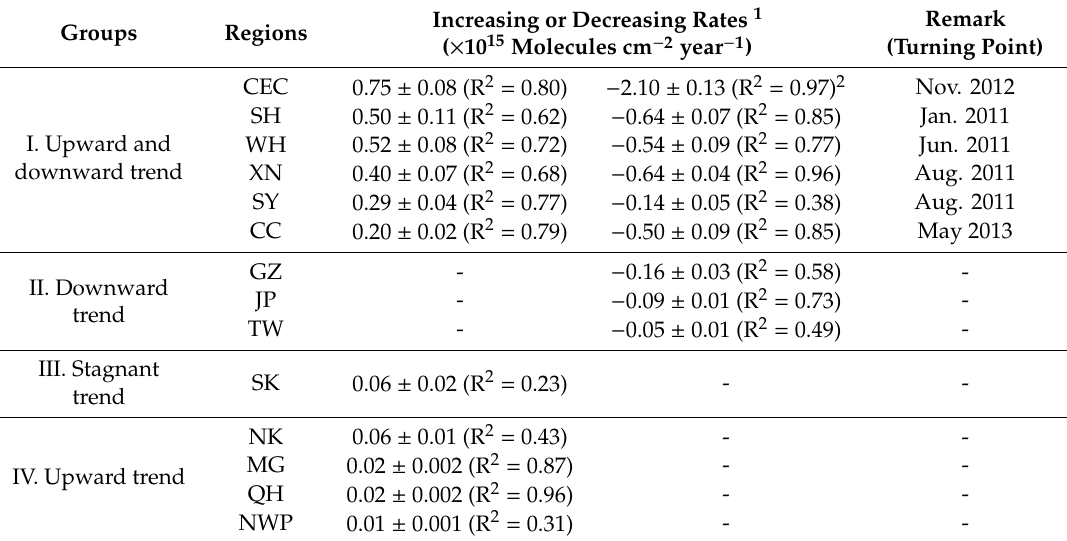
Table 1. Increasing or decreasing rates based on the 12-month moving averages.